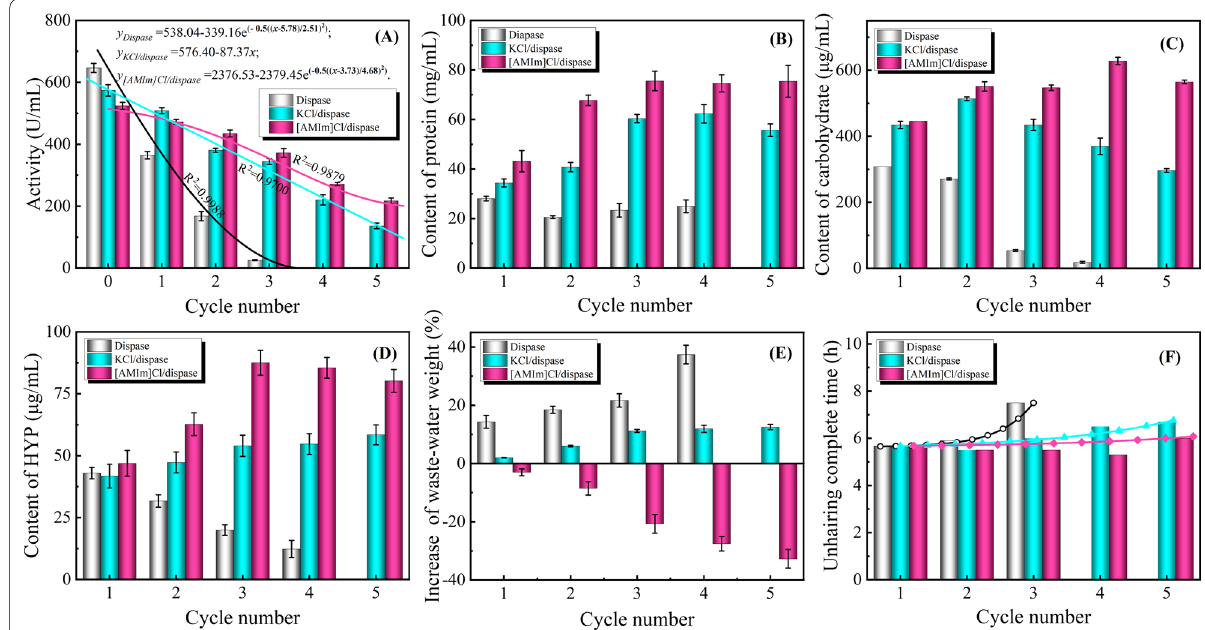
Fig. 1 The changes of the dispase activity ( A ), protein content ( B ), carbohydrate content ( C ) and HYP content ( D ) in wastewater, the wastewater weight ( E ) and unhairing complete time ( F ) after each cycle unhairing by dispase, KCl/dispase and [AMIm]Cl/dispase